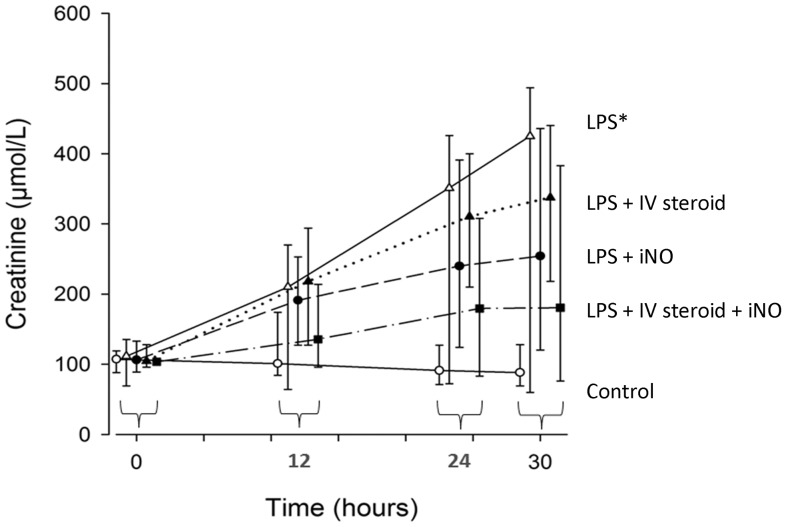
Changes in serum creatinine levels over time, unit  = µmol/L. LPS  =  lipopolysaccharide, IV steroid  =  intravenous hydrocortisone, iNO  =  inhaled nitric oxide.Values are shown as median and range. Data have been collected at 0, 12, 24 and 30(*: p = 0.02). No significances between treatment groups (IV steroid, iNO, IV steroid + iNO) and LPS alone were noted.